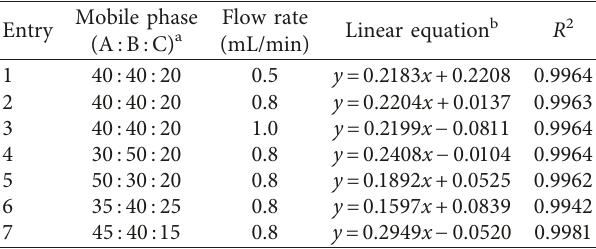
Table 1: Linearity of the log 10 RT versus DPs (2–6) of COS sep- arated by HPAEC on a CarboPacPA-100 column.